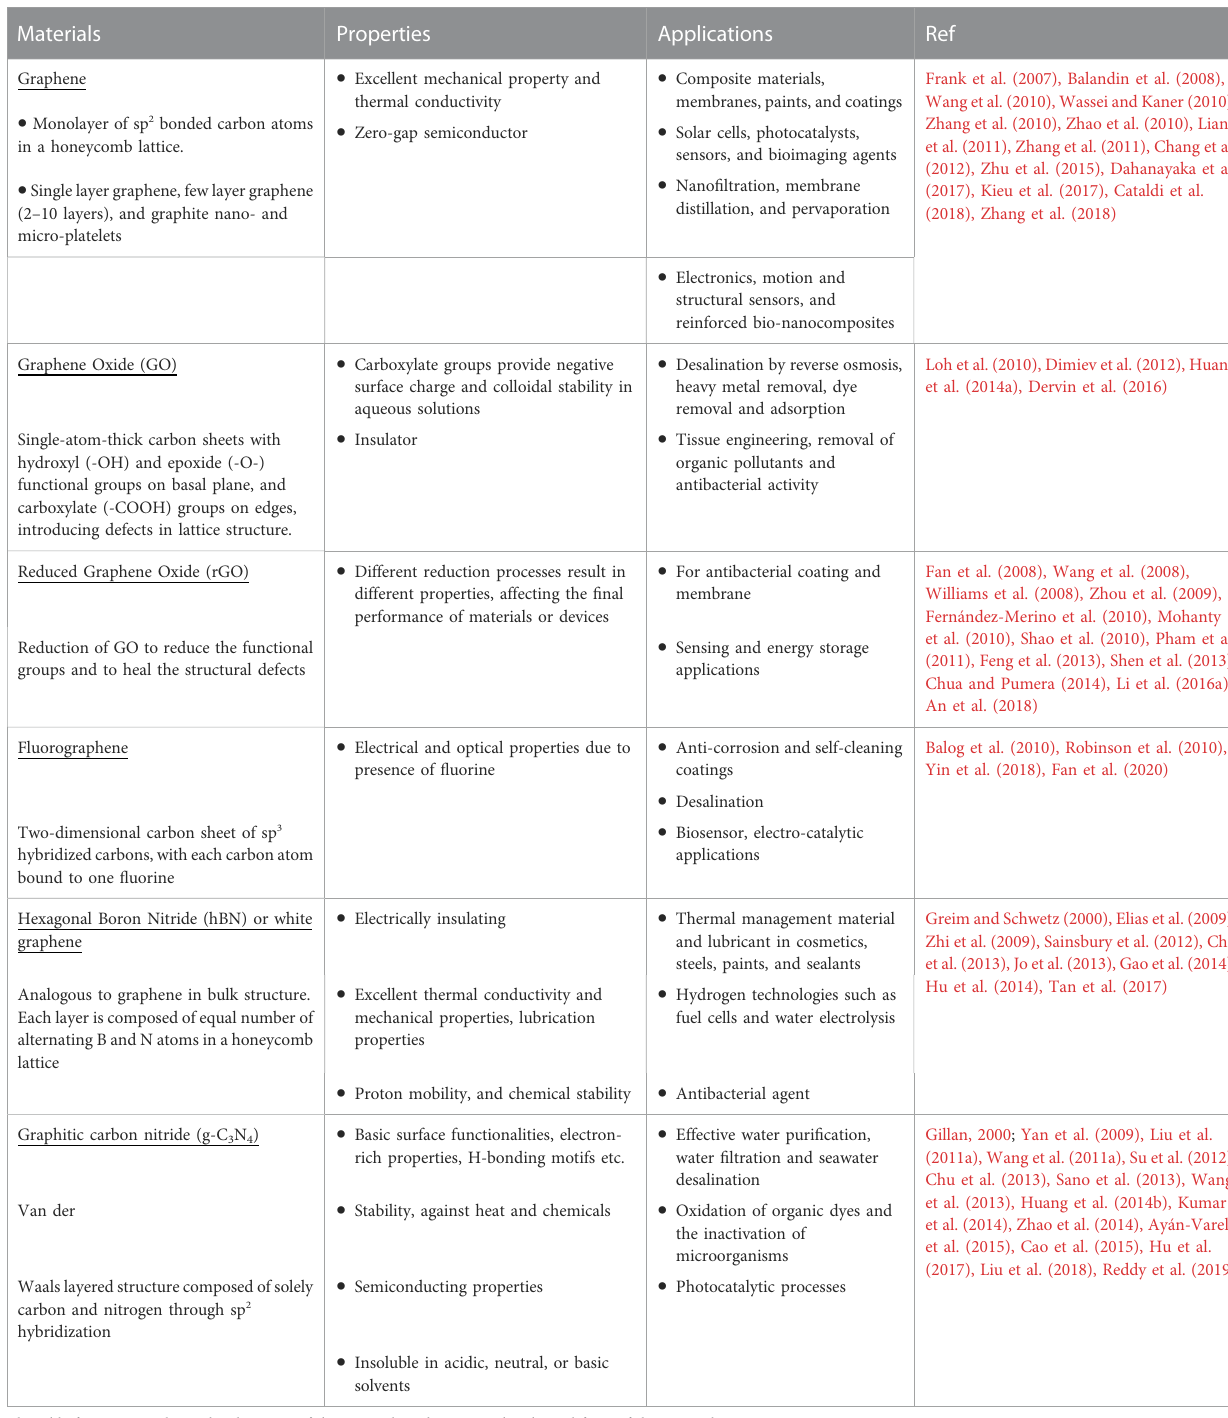
TABLE 1 Properties and applications of graphene family